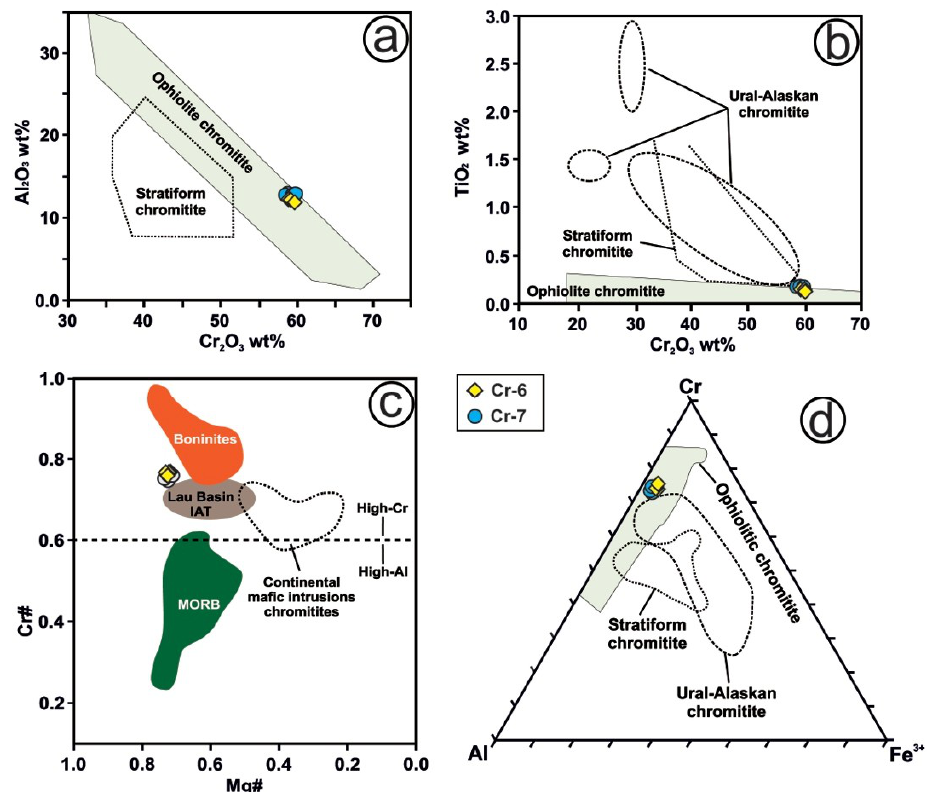
Figure 2. Chemical composition of chromite forming the North Andaman chromitites in terms of: ( a ) Al 2 O 3 versus Cr 2 O 3 (wt.%); ( b ) TiO 2 versus Cr 2 O 3 (wt.%); ( c ) Cr# [(Cr / Cr + Al) atomic ratio] versus Mg# [(Mg / Mg + Fe 2 + ) atomic ratio]; ( d ) Fe 3 + —Cr—Al (atomic element) ternary diagram. Data sources